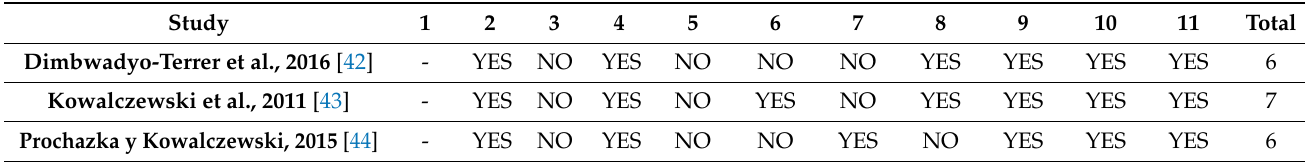
Table 3. PEDro scores obtained by the different studies included in the systematic